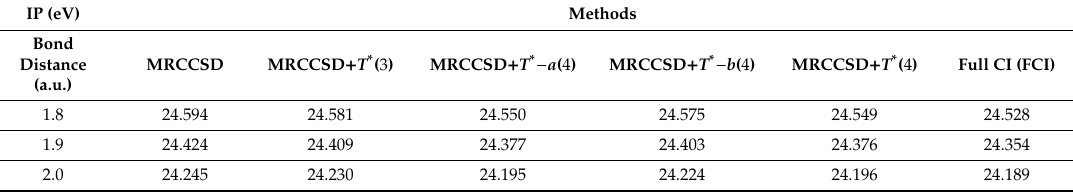
Table 5. Vertical IP of CH + (lowest) in cc-pVDZ basis in